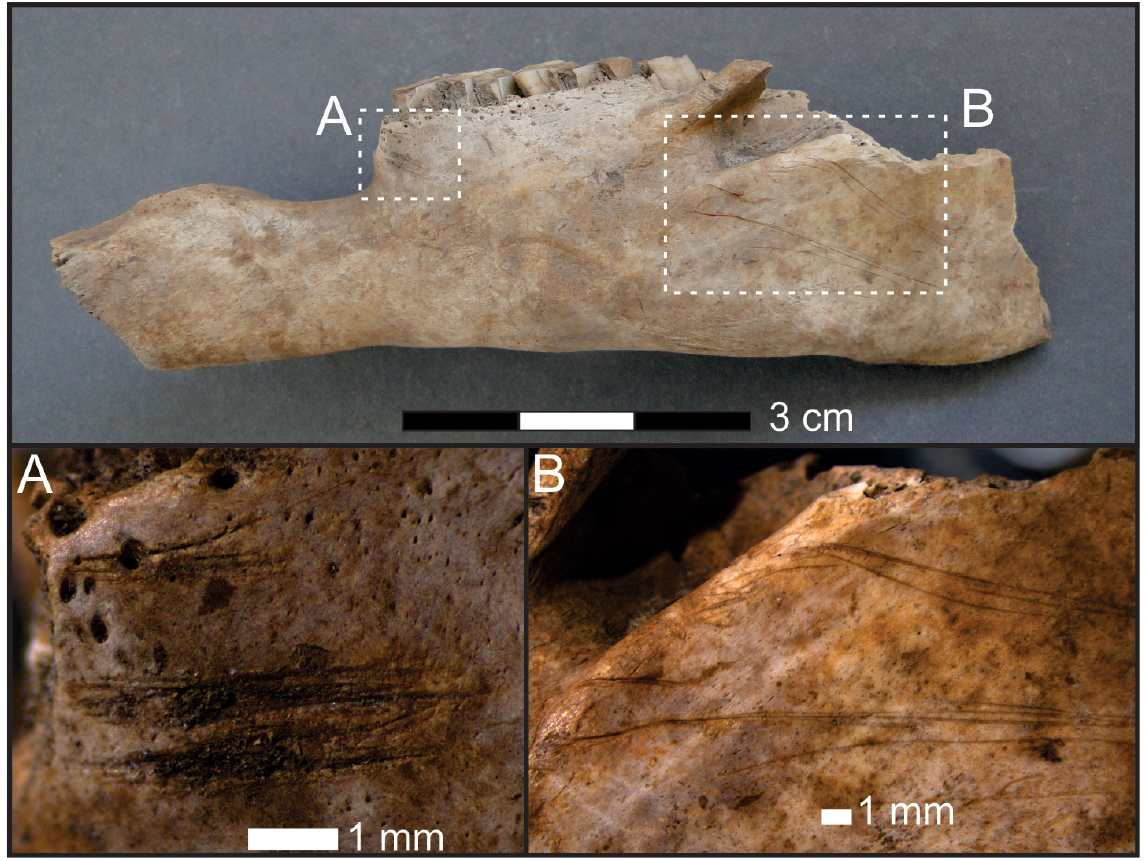
Figure 5. Cut marks recorded in Plains viscacha